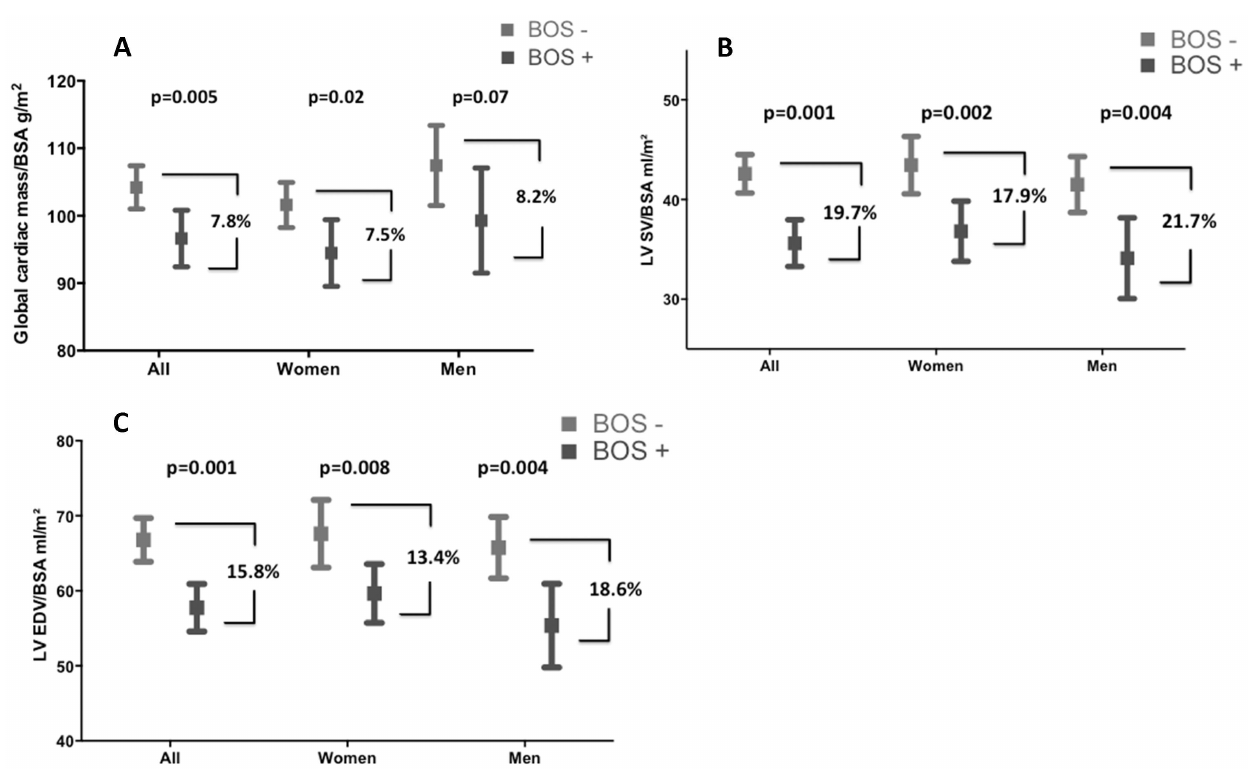
Figure 2. Changes of cardiac parameters. A. Adjusted values of global cardiac mass/BSA (RV + LV mass/BSA) compared BOS 0/0p and BOS1–3 for all patients and for men and women. In all groups a nearly 8% difference in global cardiac mass is seen. B Adjusted values of left ventricular stroke volume/ BSA compared BOS 0/0p and BOS1–3 for all patients and for men and women. In all groups a 20% difference in stroke volume is seen. C Adjusted values of left ventricular end-diastolic volume/BSA compared BOS 0/0p and BOS1–3 for all patients and for men and women. In all groups a significant difference in end-diastolic volume is seen. Shown are mean values and 95%-confidence interval.